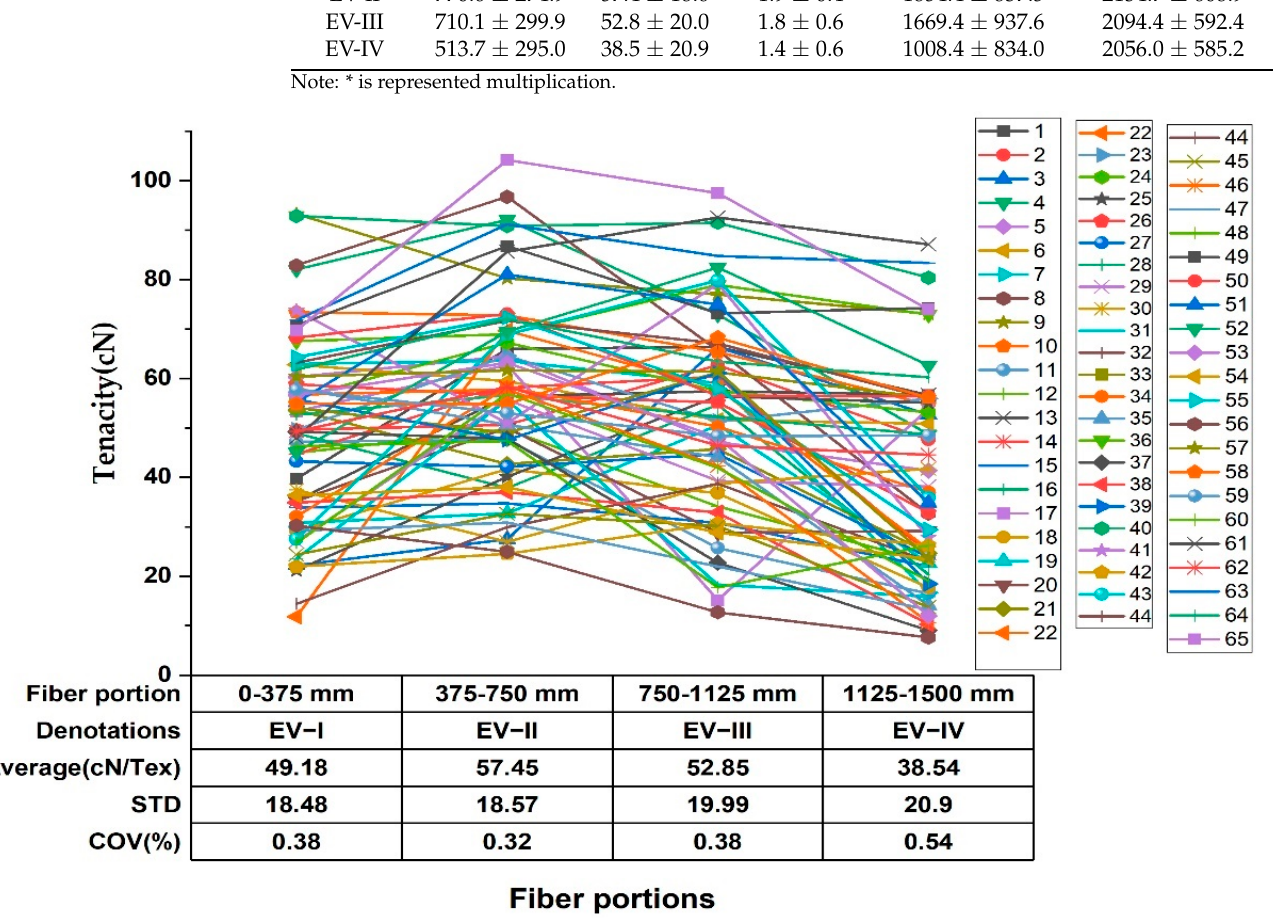
Table 2. The mechanical properties of Enset fiber.